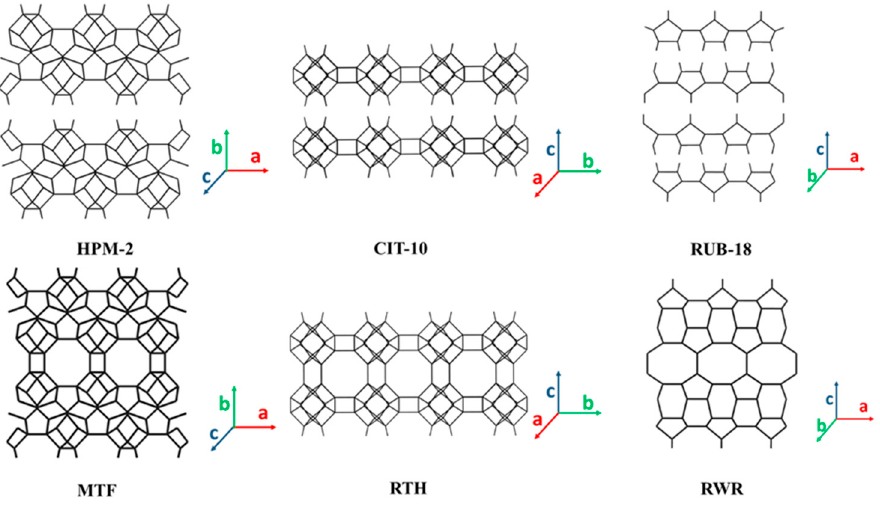
Figure 6. Schematic illustration of structures of 2D layered zeolite precursors, and their corresponding 3D MTF (MCM (Mobil Composition of Matter)-35 (thirty-five)), RTH and RWR zeolites.